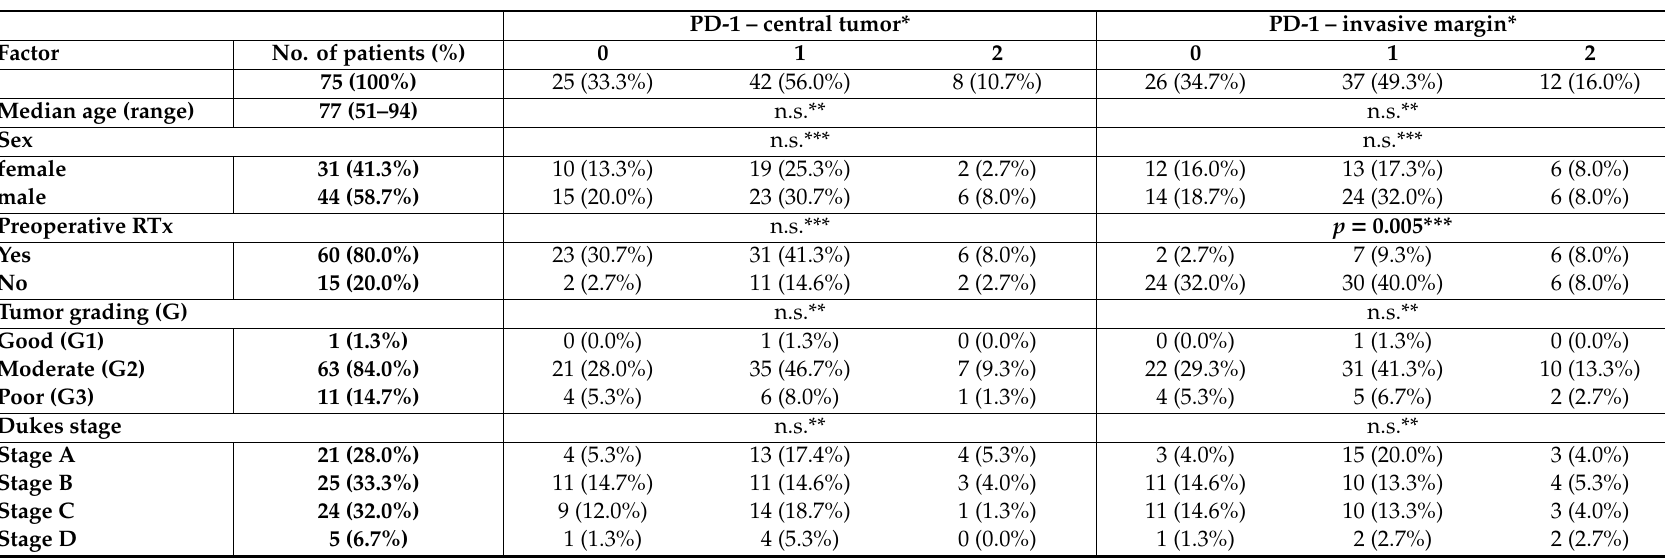
Table 3. Patient and tumor characteristics in relation to the level of PD-1 immune checkpoint protein expression determined analogously on full tissue sections. PD-1 – central tumor* PD-1 – invasive